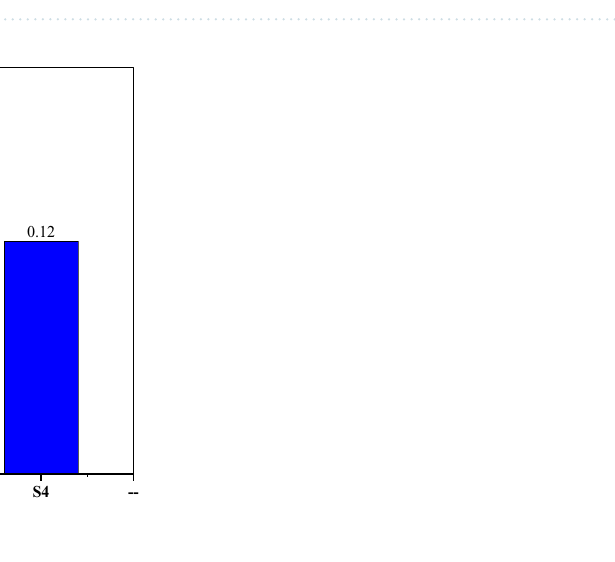
Figure 18. Variation of the radiation protection efficiency with energy for 20Bi 2 O 3 − xPbO − (80 − 2x) B